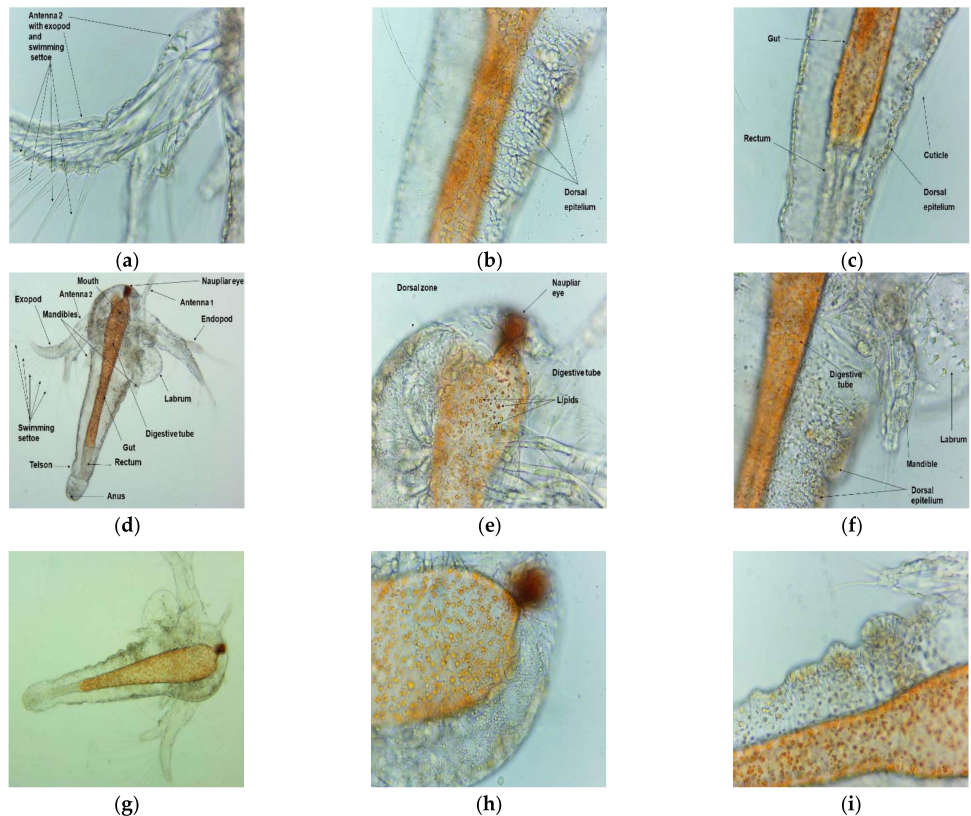
Figure 5. Microscopic images of A. salina nauplii morphology after 30 h (summing both steps times of BSL-assay, 24 h + 6 h) of exposure in saline solution 0.3% ( a – f ) and Poloxamer 407 at 3:1 dilution ( g – i ) with different magnifications: 100 × ( d , g ) and 400 × ( a – c , e , f , h , i